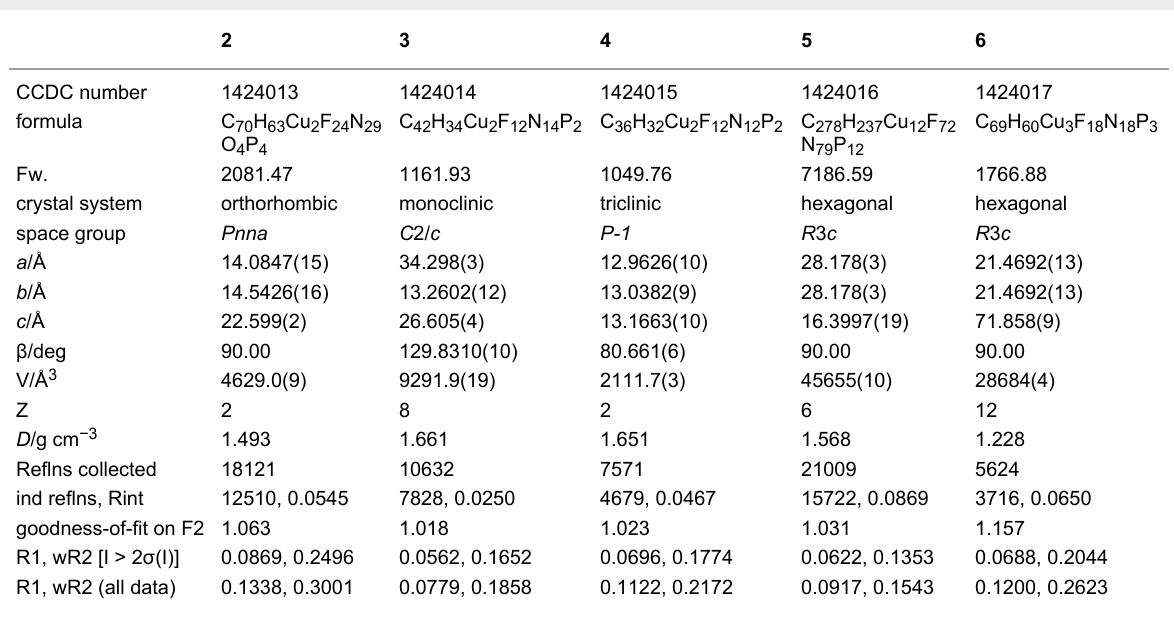
Table 3: Crystallographic data for complexes 2 – 6